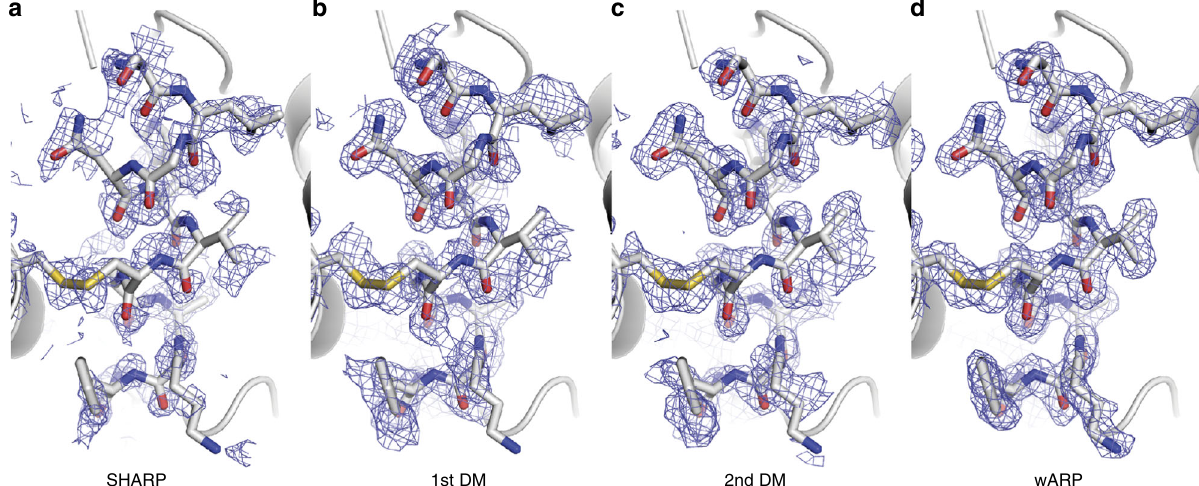
Fig. 3 Progression of the MAD phasing process with 5,000 images. a SHARP 36 phases. b Phases after fi rst round of density modi fi cation. c Phases after second round of density modi fi cation (DM, taking the fi rst round of model building into account). d Phases after automatic building and -re fi nement by ARP/wARP 38 . All maps are contoured at 1.0 σ and are superimposed onto the fi nal, re fi ned structure (PDB code